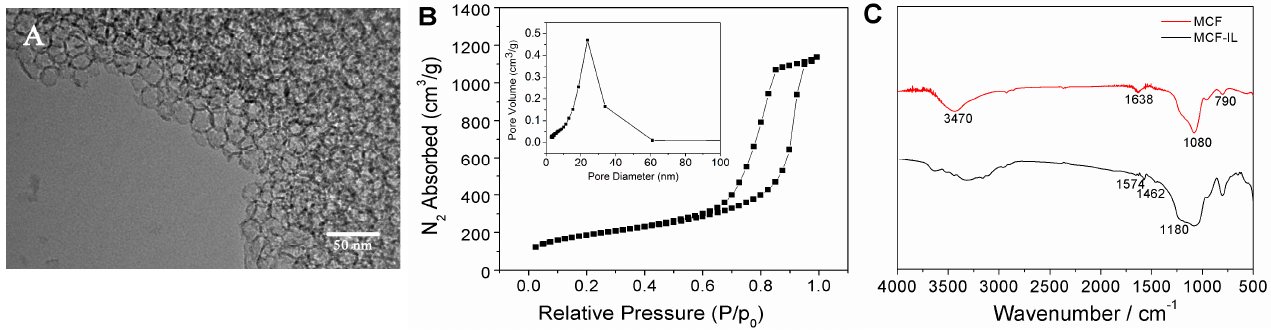
Figure 1. ( A ) TEM micrograph of MCF; ( B ) N 2 adsorption–desorption isotherms and BJH (inset) and ( C ) FT-IR spectra of MCF and MCF-IL.